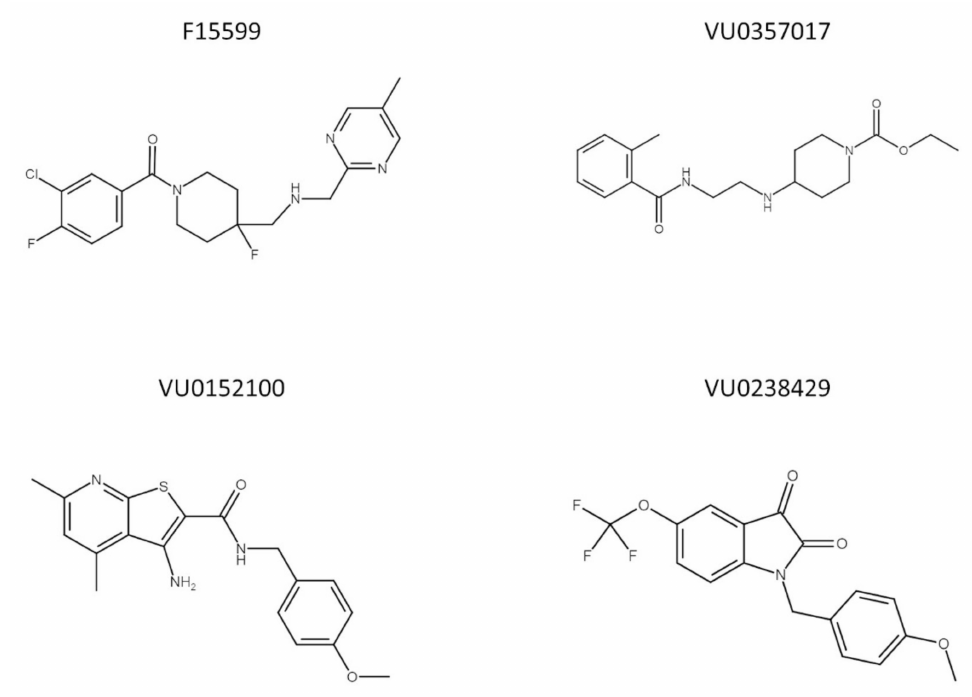
Figure 1. Chemical structure of F15599, VU0357017, VU0152100, and